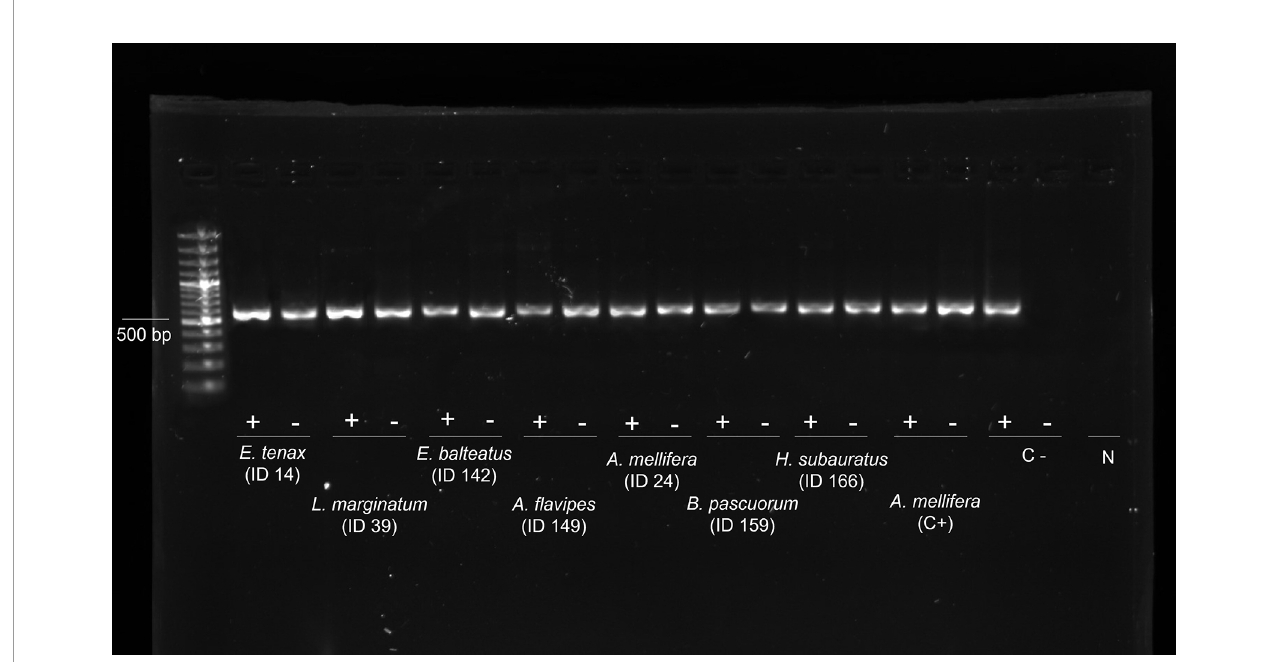
FIGURE 2 | Evidence of genomic and replicative DWV strands. Gel electrophoresis of strand-speci fi c RT-PCR of the cDNA from 8 individuals: genomic strand (+) and replicative strand ( − ). Positive control (C+): cDNA from replicative DWV of Apis mellifera workers. Negative control (C − ): non-replicative DWV of A. mellifera workers. N: DNA- and Rnase-free water. DWV, deformed wing